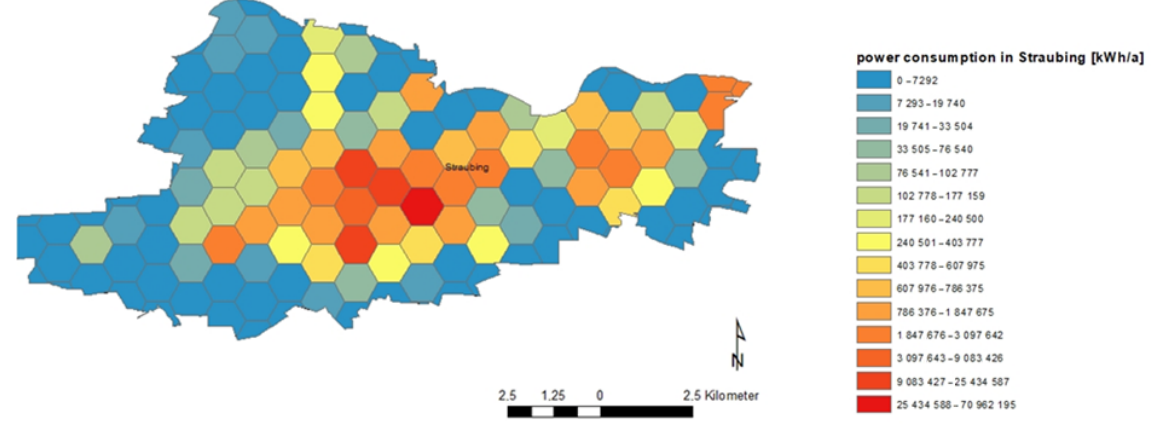
Figure 5. Estimated location of the annual electricity consumption of the village of Straubing.